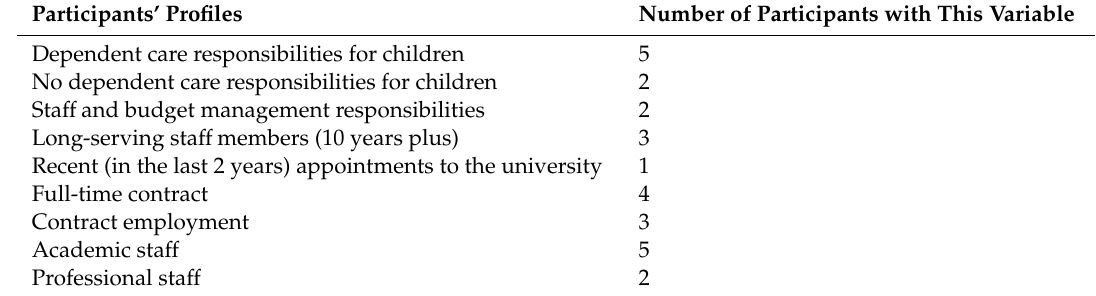
Table 1. Participants in an autoethnographic study of lived experience of gender at a regional Australian university